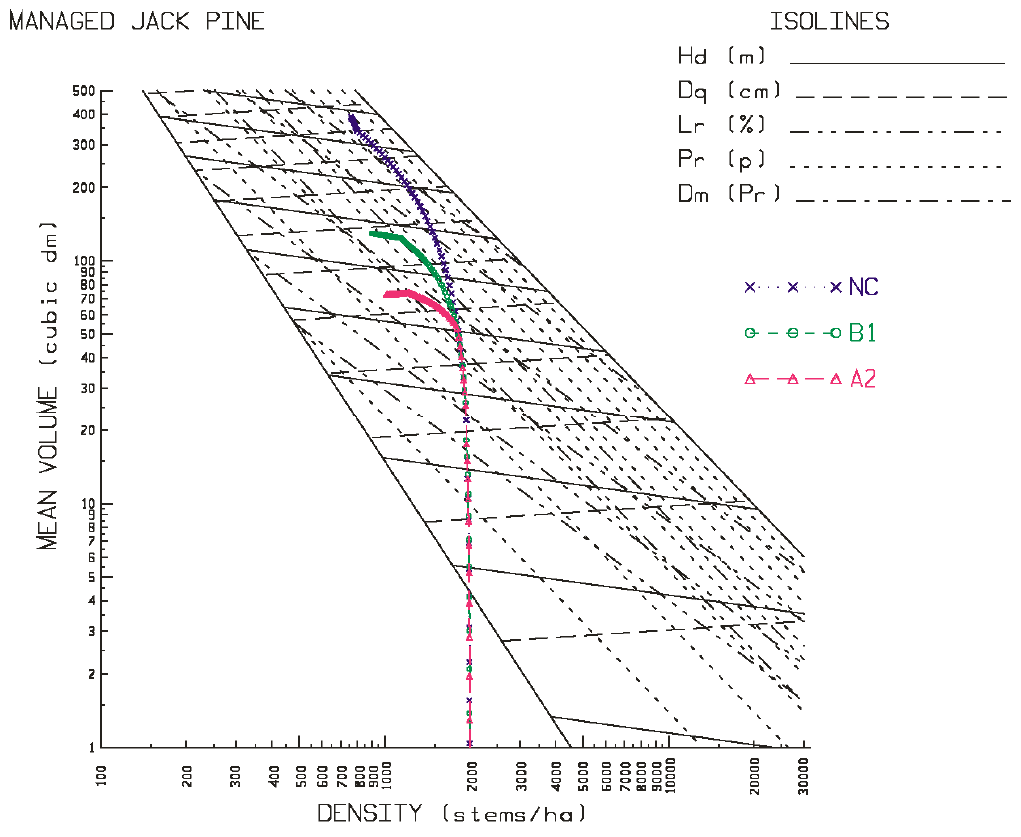
Figure 4. Temporal size-density trajectories by scenario for jack pine plantations within the context of the SSDMM graphic for good-to-excellent quality sites ( S I = 12.4) within north-western Ontario. Note, all graphical denotations and definitions follow that given in the caption of Figure 3. Source: Modified SSDMM for jack pine.